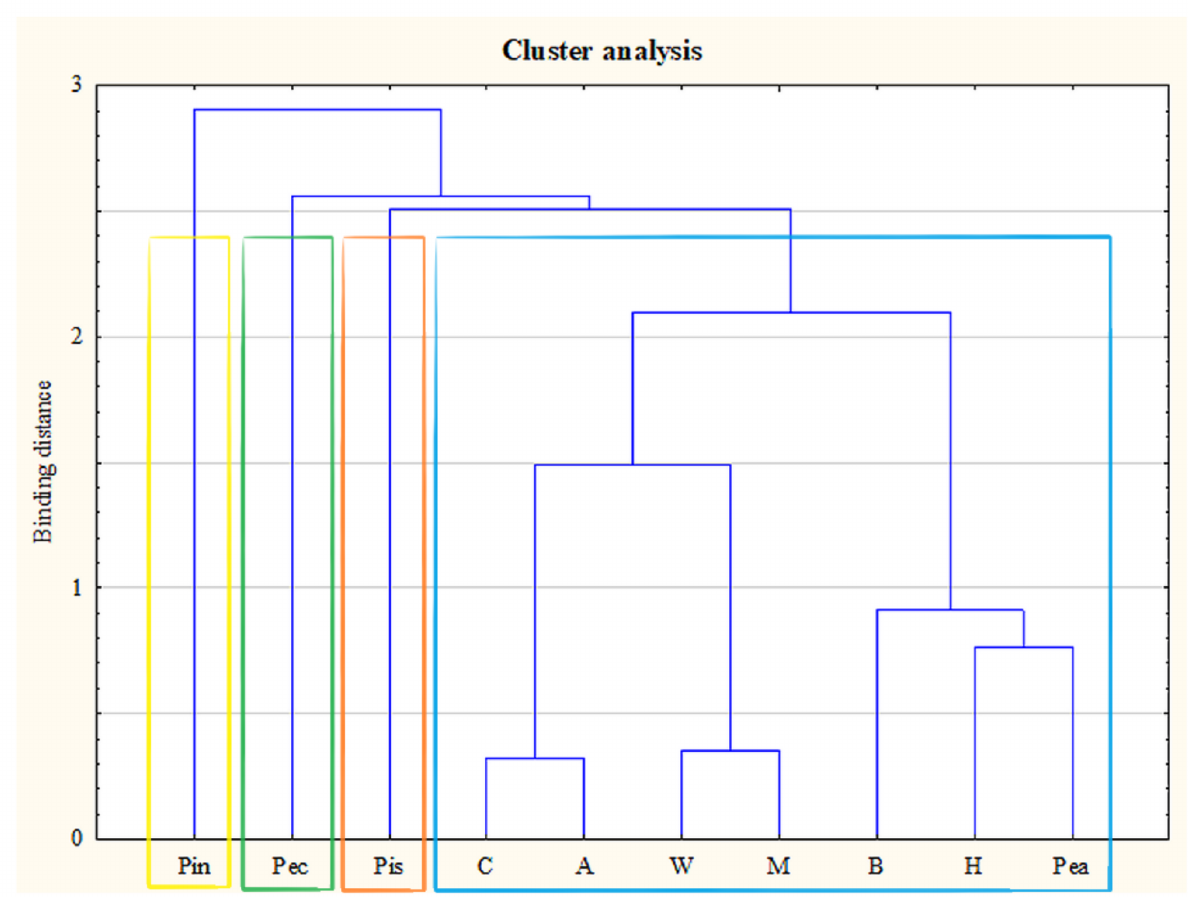
Figure 2. Dendrogram based on the content of toxic elements. A — almonds; B — Brazil nuts; C — cashews; H — hazelnuts; M — macadamia nuts; Pea — peanuts; Pec — pecans; Pin — pine; Pis — pistachios; W — walnuts.